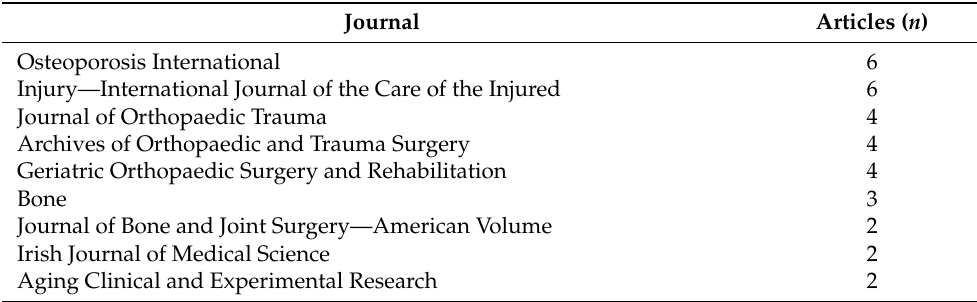
Table 4. List of journals with more than one article within the identified articles.